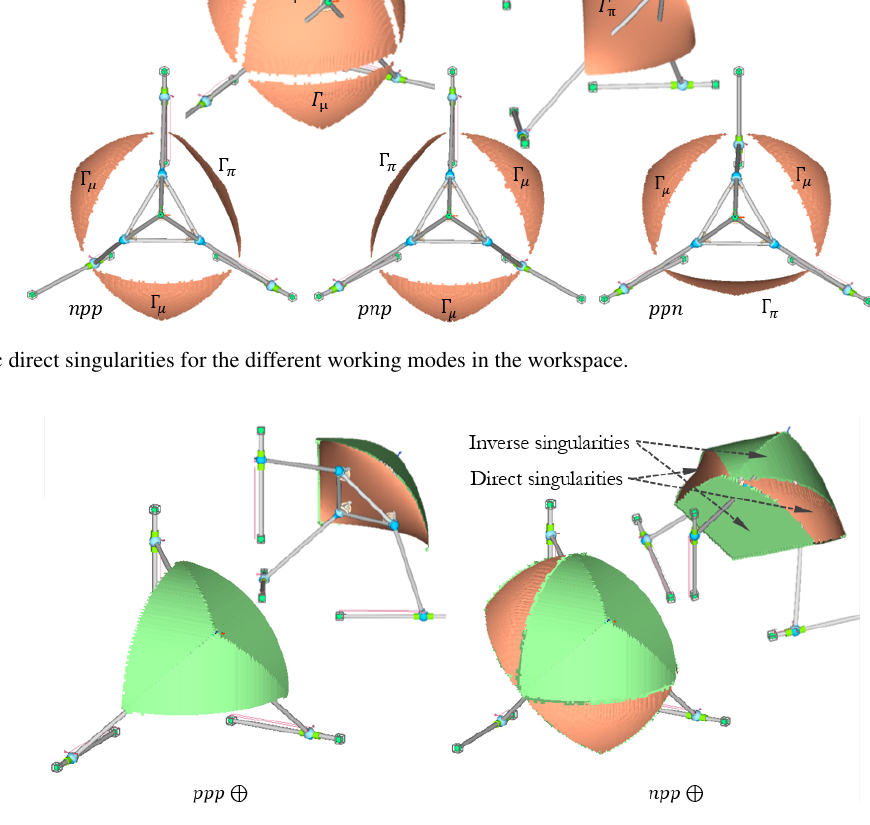
Figure 19. Singularity-free regions for two of the eight working modes (two different views for each one).